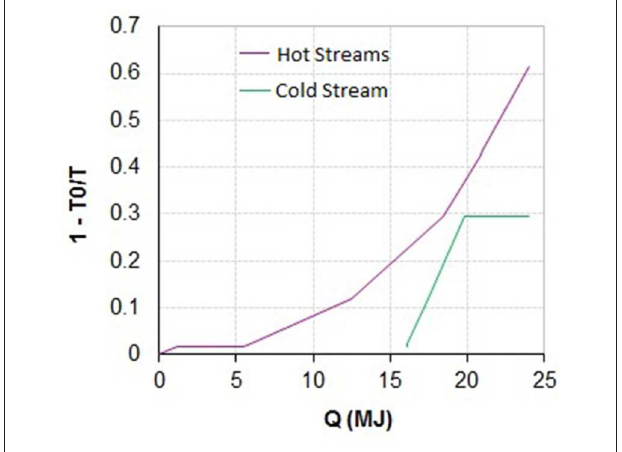
FIGURE 5 | Q vs. 1-T0/T plot for CO 2 capture system (1l diesel); T0 (reference temperature) = 298K.